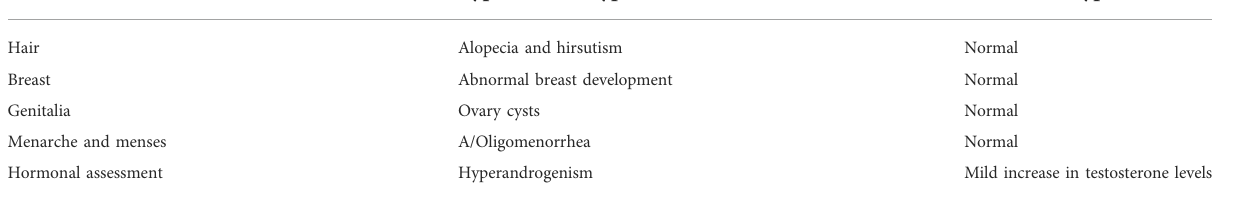
TABLE 2 Typical and mild gynecological phenotype of Alström